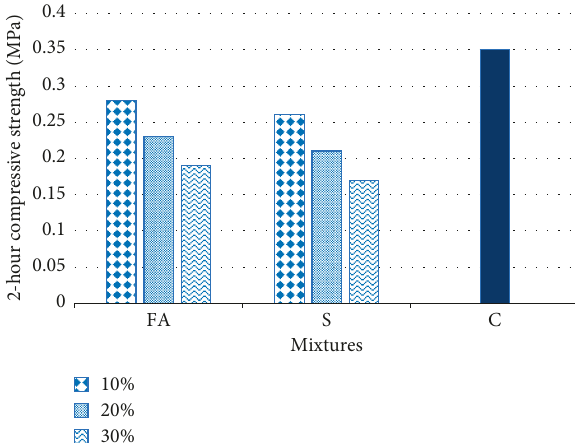
Figure 8: 2-hour unconfined compressive strength test results of CAM mixtures.